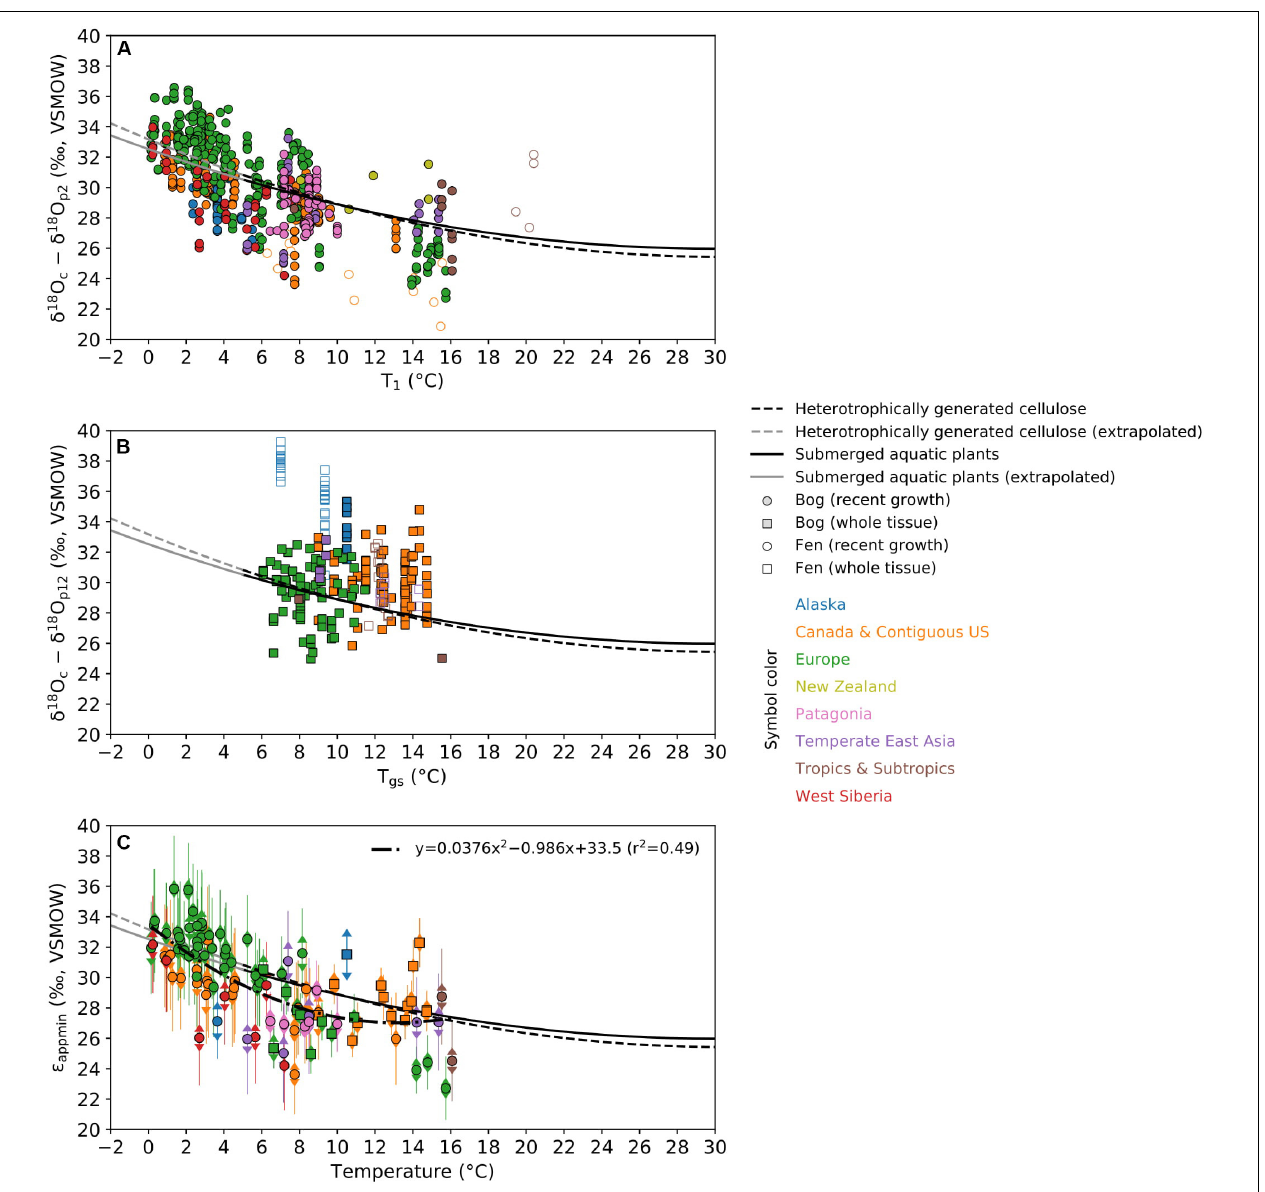
FIGURE 4 | The relationship between ε app and temperature. Symbols are color-coded to represent different regions as in Figure 1 . (A) All data for the recent growth of Sphagnum are plotted using the pair of δ 18 O c – δ 18 O p 2 and T 1 . (B) All data for the whole plant of Sphagnum are plotted using the pair of δ 18 O c – δ 18 O p 12 and T gs . (C) The biplot between the site-specific ε appmin and growth temperature for bog sites with at least three measurements. The 95% prediction interval of OIPC-based mean annual δ 18 O p at each sampling location is shown as error bar with arrow caps. The precision (2 σ ) of ε appmin is denoted as error bar without caps. These data were fitted by a second order polynomial regression shown by the dash-dotted line. Also shown in these figures are the second order polynomial regressions fitted by data from heterotrophic generation of cellulose and data from submerged aquatic plants by Sternberg and Ellsworth (2011) as well as their extrapolations. Note that the full range of temperature (to 30 ◦ C) in laboratory experiments by Sternberg and Ellsworth (2011) is shown to illustrate that the sensitivity of ε app to temperature is very weak at high